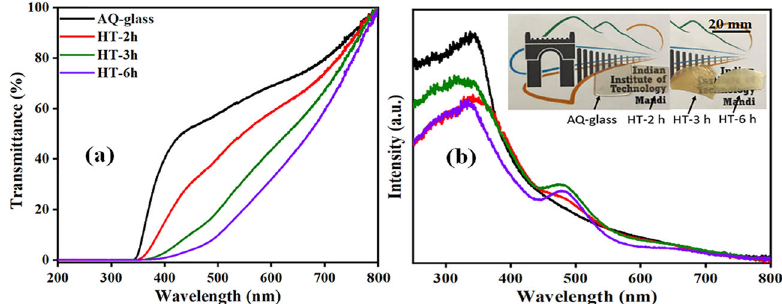
Fig. 4 Transmittance and absorbance spectra. a Transmittance spectra of AQ-glass, HT-2h, HT-3h, and HT-6h samples indicating the decrease in transparency from AQ-glass to the HT-6h sample and b absorbance spectra of AQ-glass, HT-2h, HT-3h, and HT-6h samples showing a signi fi cant blue shift in the absorbance edge of HT-6h sample than that of AQ-glass, HT-2h, and HT-3h, samples.